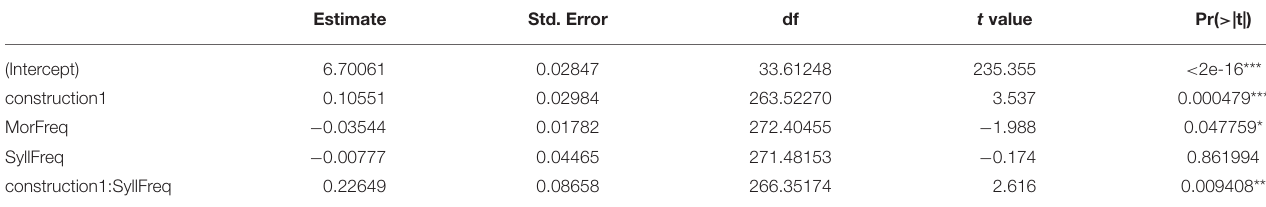
TABLE 5 | Best fitting model for T2-RED vs. T3-RED comparison.